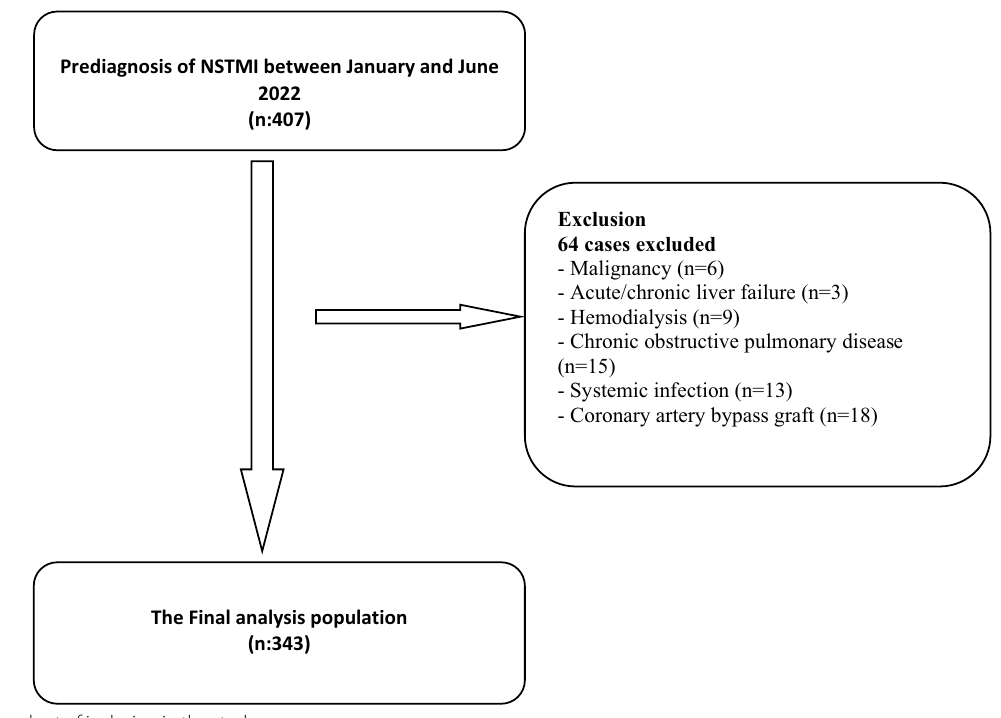
Fig. 1 Flowchart of inclusion in the